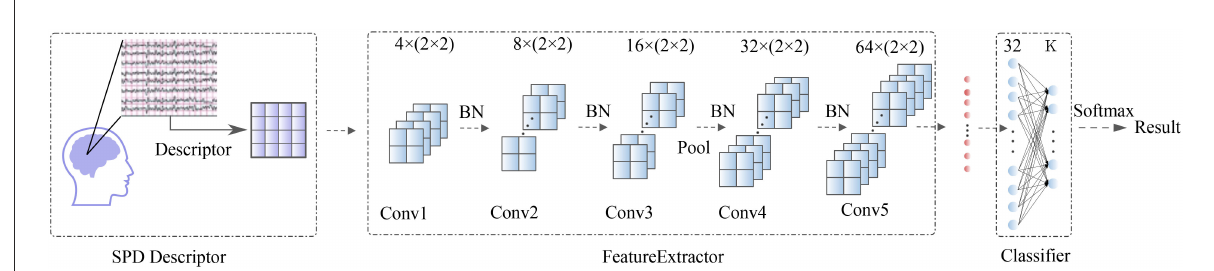
FIGURE1 Overall visualization of the SPD-CNN architecture. It starts with an SPD descriptor to transform EEG into SPD matrices, then the matrices are encoded by Feature Extractor Block and flattened as the input data of the classification block. In the classification block, the features are passed to a two-fully connected layer and put into a soft-max classification with K units, K is the number of classes in the data.